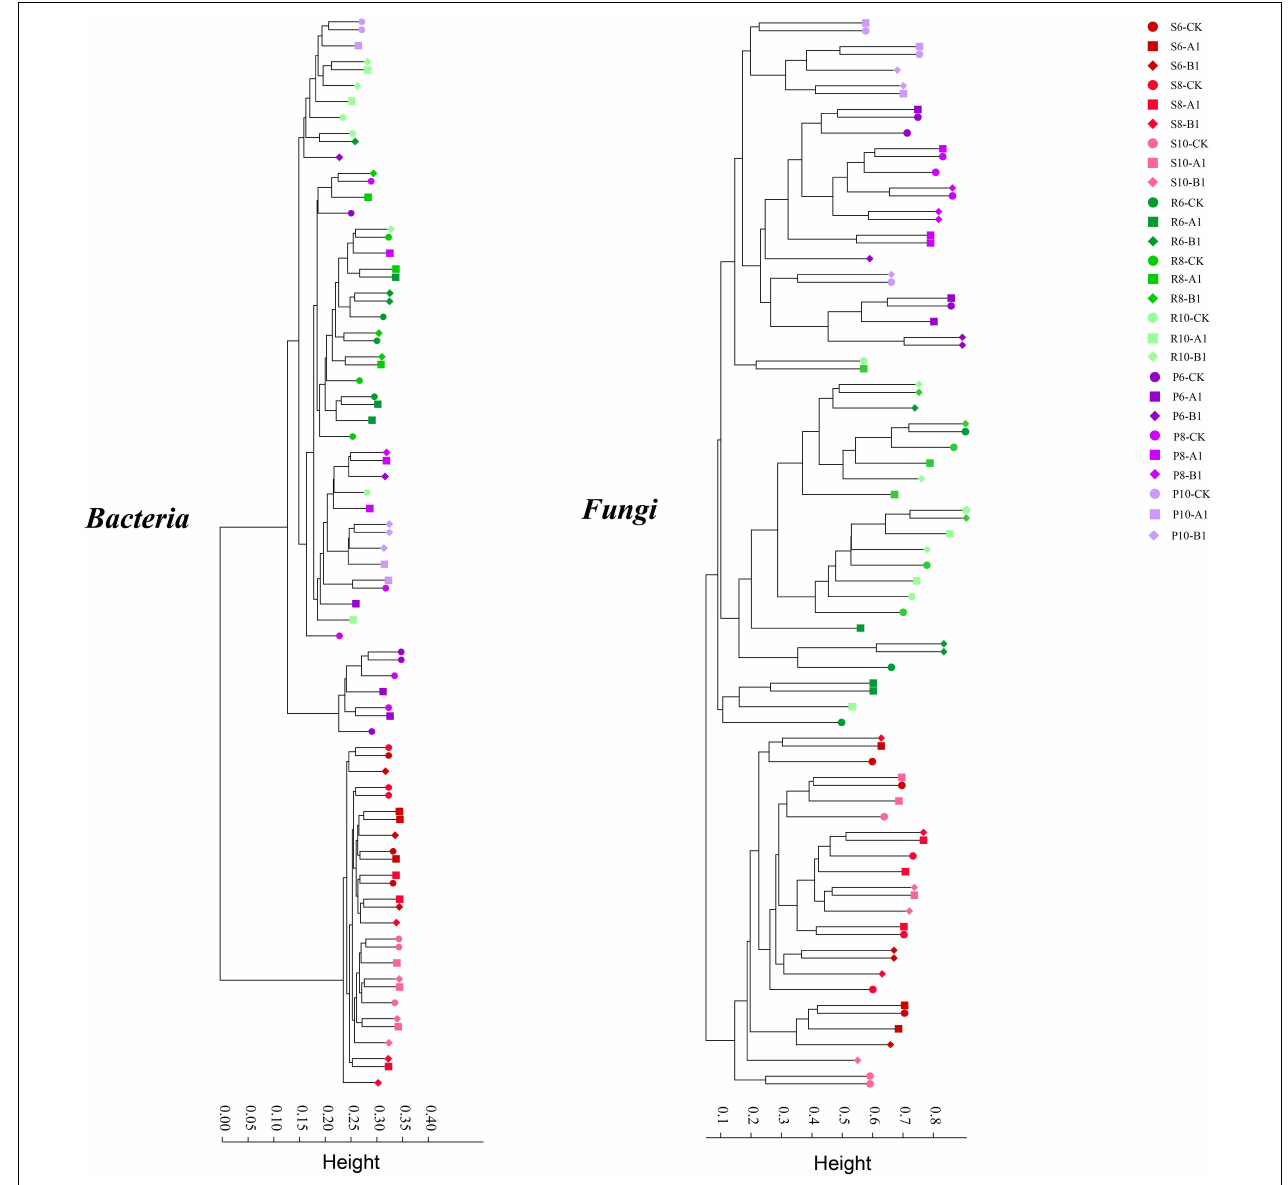
FIGURE 2 | Results of a cluster analysis based on the UniFrac distance of all samples at a 3% cut-off OTU level in 16S and